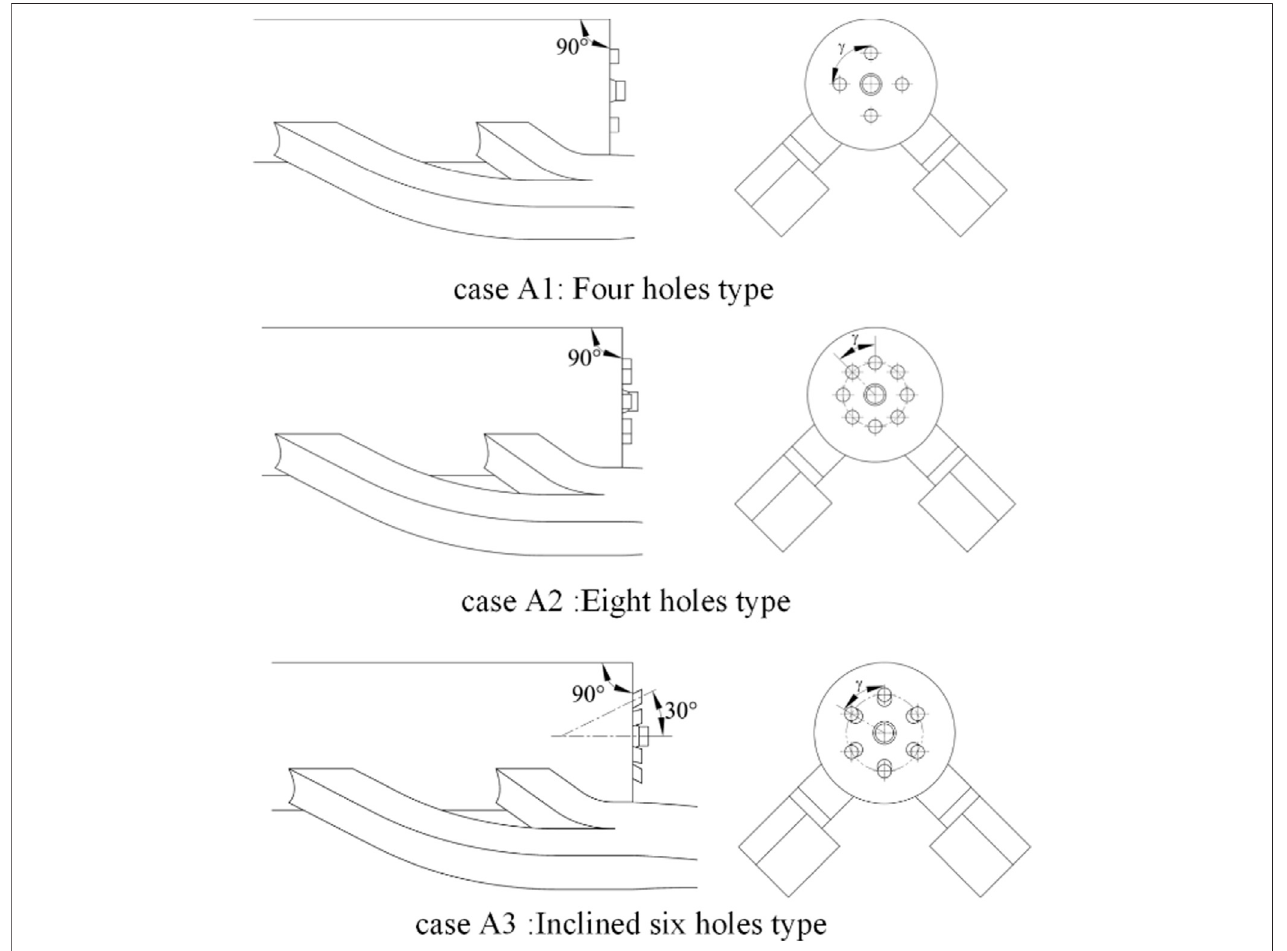
FIGURE 4 | Different designs of exhaust inlet patterns mounted on the combustion